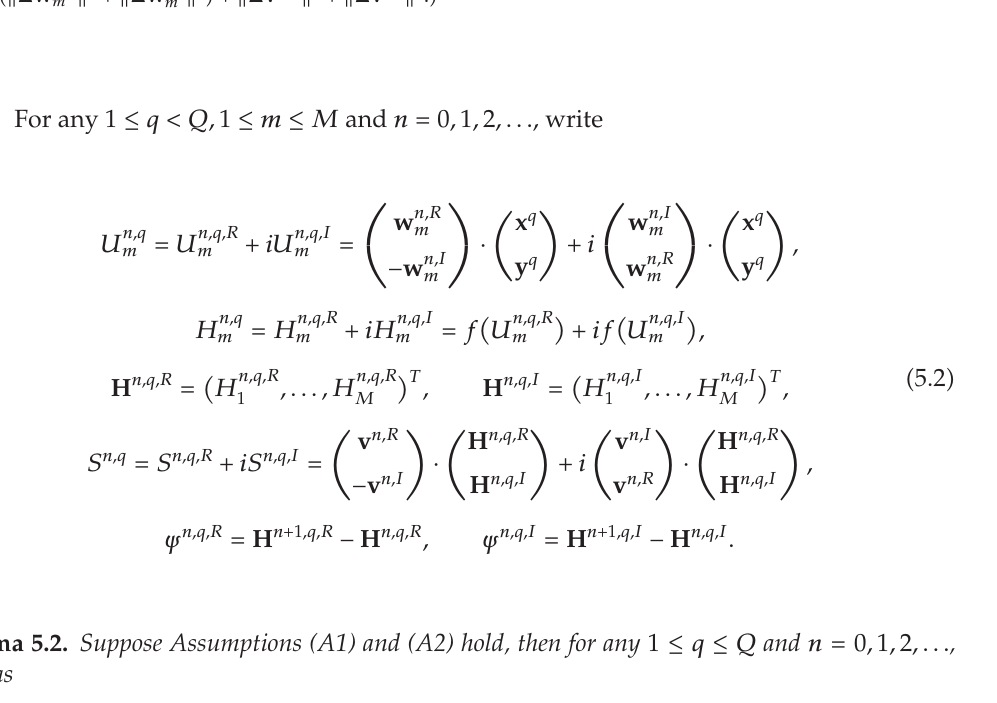
(cid:8) 2 (cid:3) (cid:8) (cid:8) Δ v n,R (cid:8) 2 (cid:8) (cid:8) Δ v n,I (cid:8) 2 . (cid:3) m